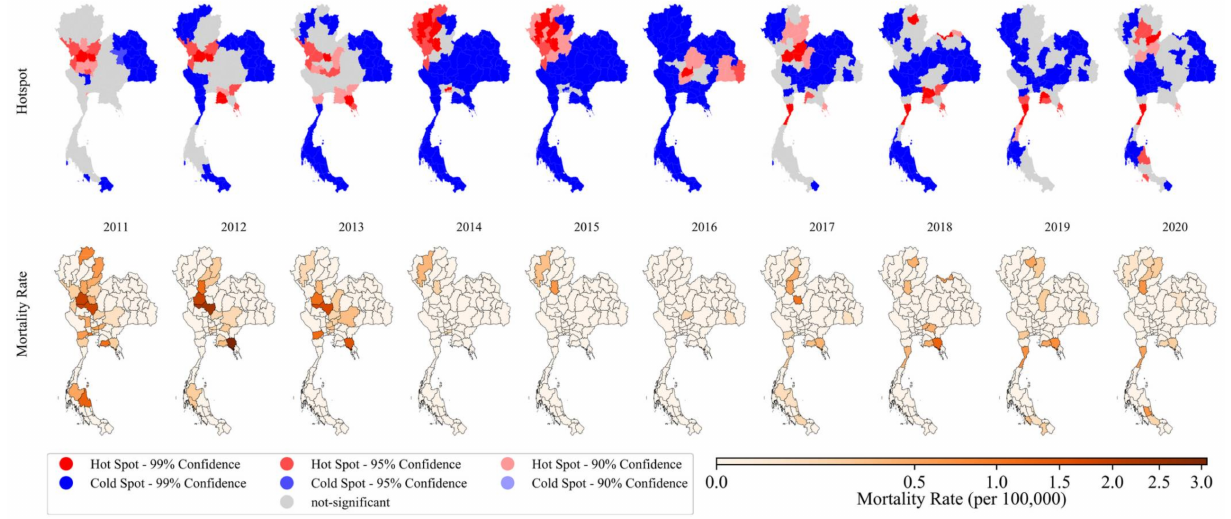
Figure 5. Maps of yearly mortality clusters using local Getis–Ord statistic (upper) and crude TB mortality rates (lower) during